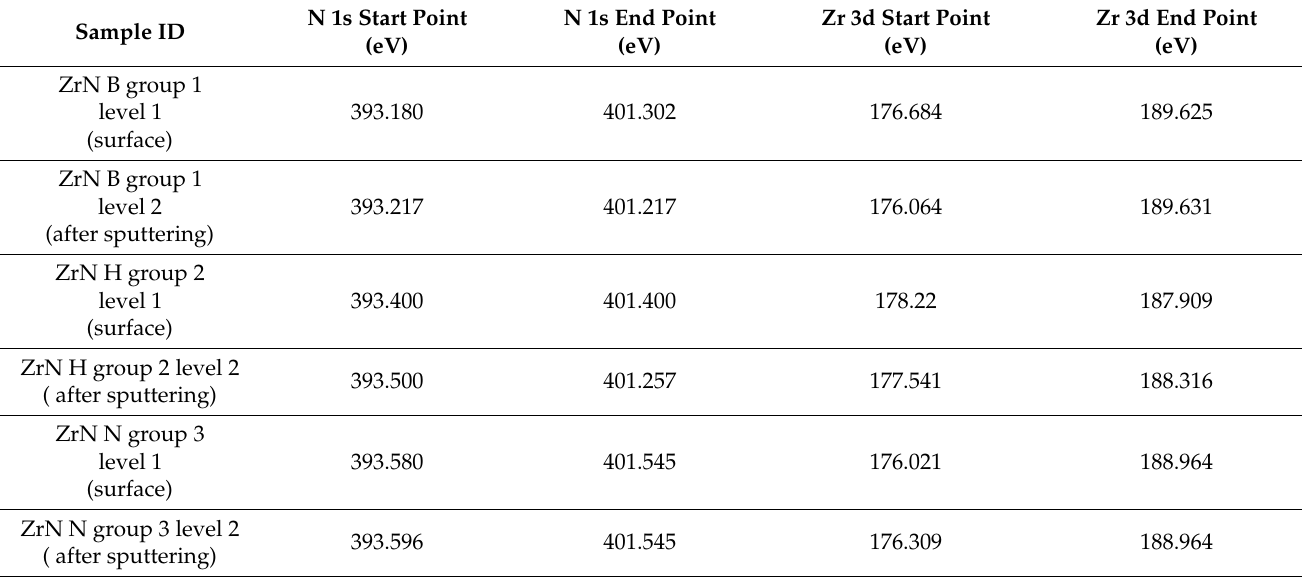
Table 2. N 1s and Zr 3d for three representative specimens of each group of